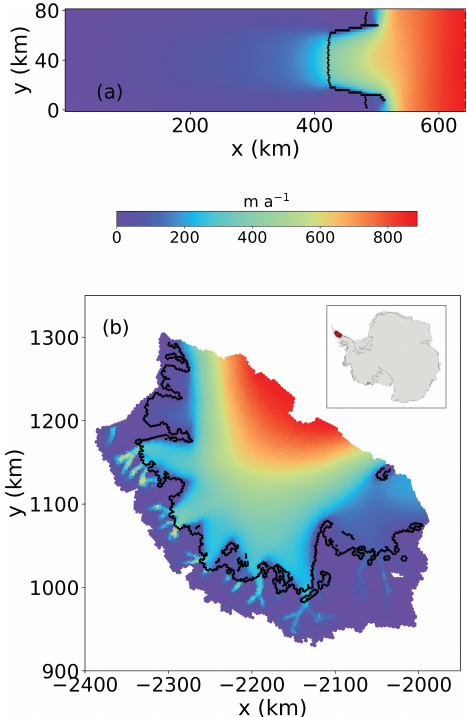
Figure 1. (a) Plan view of surface speed for the MISMIP + and (b) Larsen C Ice Shelf experimental domains. For the Larsen C do- main, velocities have been optimized to match observations from Rignot et al. (2011). Black curves indicate the location of the grounding line. The location of the Larsen C Ice Shelf is shown as the shaded area in the inset in (b) . A comparison of modeled and observed ice surface speed is provided in Fig. S1 in the